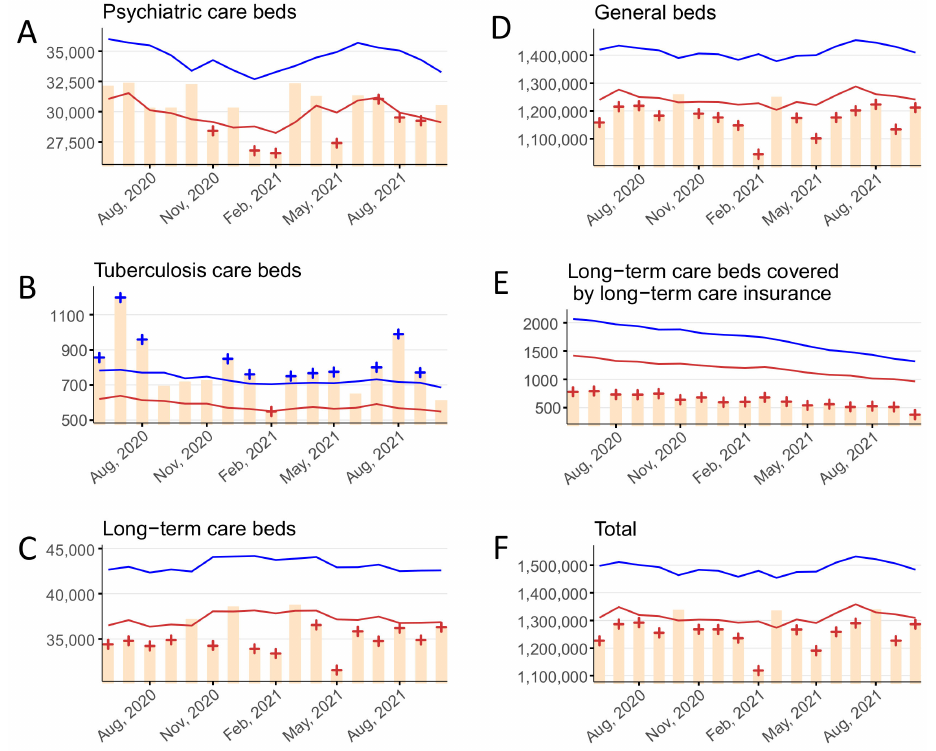
Figure 4. The monthly number of new hospitalizations stratified by bed type, June 2020–October 2021 in ( A ) psychiatric beds, ( B ) tuberculosis beds, ( C ) long-term care beds, ( D ) general beds, ( E ) long-term care beds covered by long-term care insurance, and ( F ) in total. Yellow bars indicate the observed number of new hospitalizations per month. Blue and red lines show the upper and lower limits, respectively, of the 95% prediction interval. Blue and red + symbols indicate statistically significant monthly excesses and deficits, respectively. Gray shading corresponds to the state of emergency declarations in